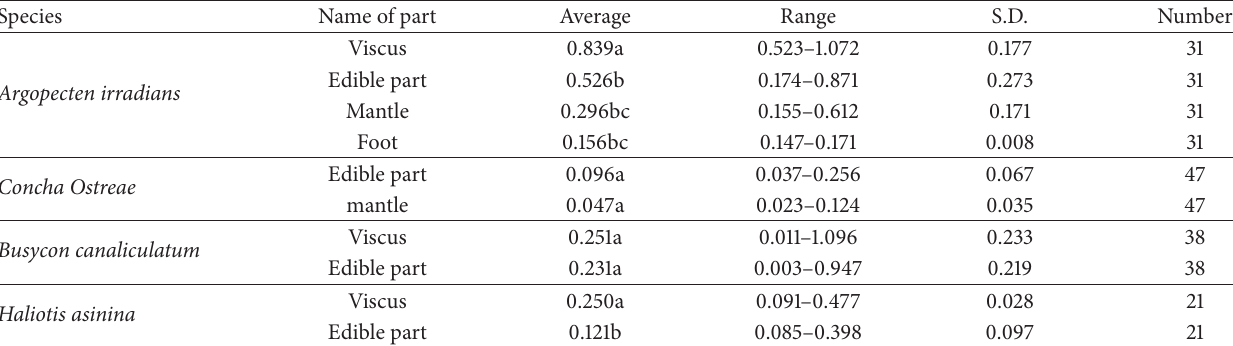
Table 2: The distribution of Hg in the different parts of shellfish samples (wet weight, mg ⋅ kg −1 ).